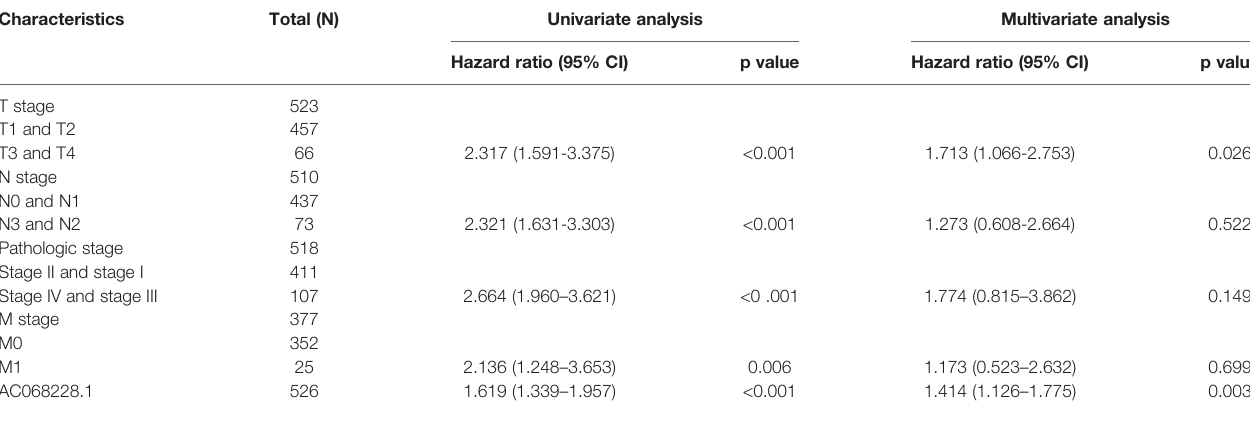
TABLE 1 | Univariate and multivariate Cox regression analyses of different parameters on overall survival in lung adenocarcinoma. Characteristics Total (N) Univariate analysis Multivariate analysis Hazard ratio (95% CI) p value Hazard ratio (95% CI) p